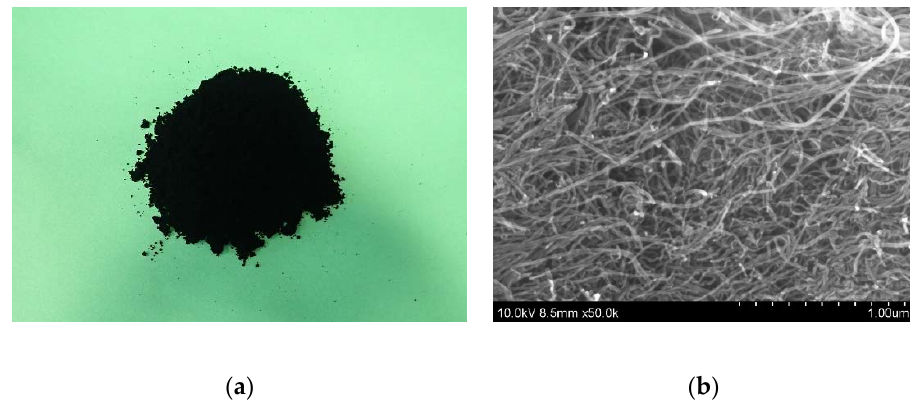
Figure 2. ( a ) nanosized alumina (n ‐ Al 2 O 3 ) with a grain diameter of approximately 20–30 nm (powdered) used in laboratory tests. ( b ): microstructure of this nanosized alumina (photograph taken under a scanning microscope) [45]. The arrow marks a single particle of n ‐ Al 2 O 3 . The tests used multi ‐ walled carbon nanotubes (MWCNTs) with an external diameter of 10–20 nm and a length of 10–30 μ m, and with purity above 95%, with a specific surface area of: 233 m 2 /g and bulk density 0.22 g/cm 3 Figure 3a,b present MWCNTs used during the tests.